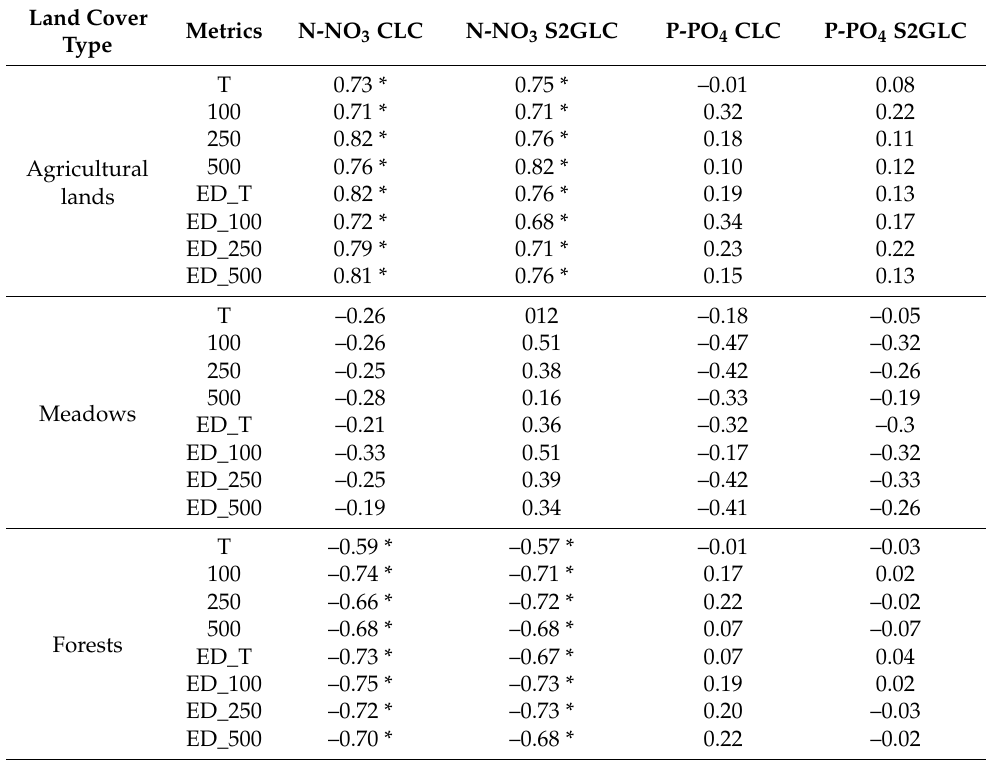
Table 4. Spearman rank correlation coefficients linking selected land cover metrics and mean N-NO 3 and P-PO 4 concentrations across investigated lowland streams during the study period from April 2019 to March 2020. Abbreviations: T, total catchment area; 100, 250, and 500, buffer zone width; ED, Euclidean distance scaling. The * indicates statistically significant correlation at the p =